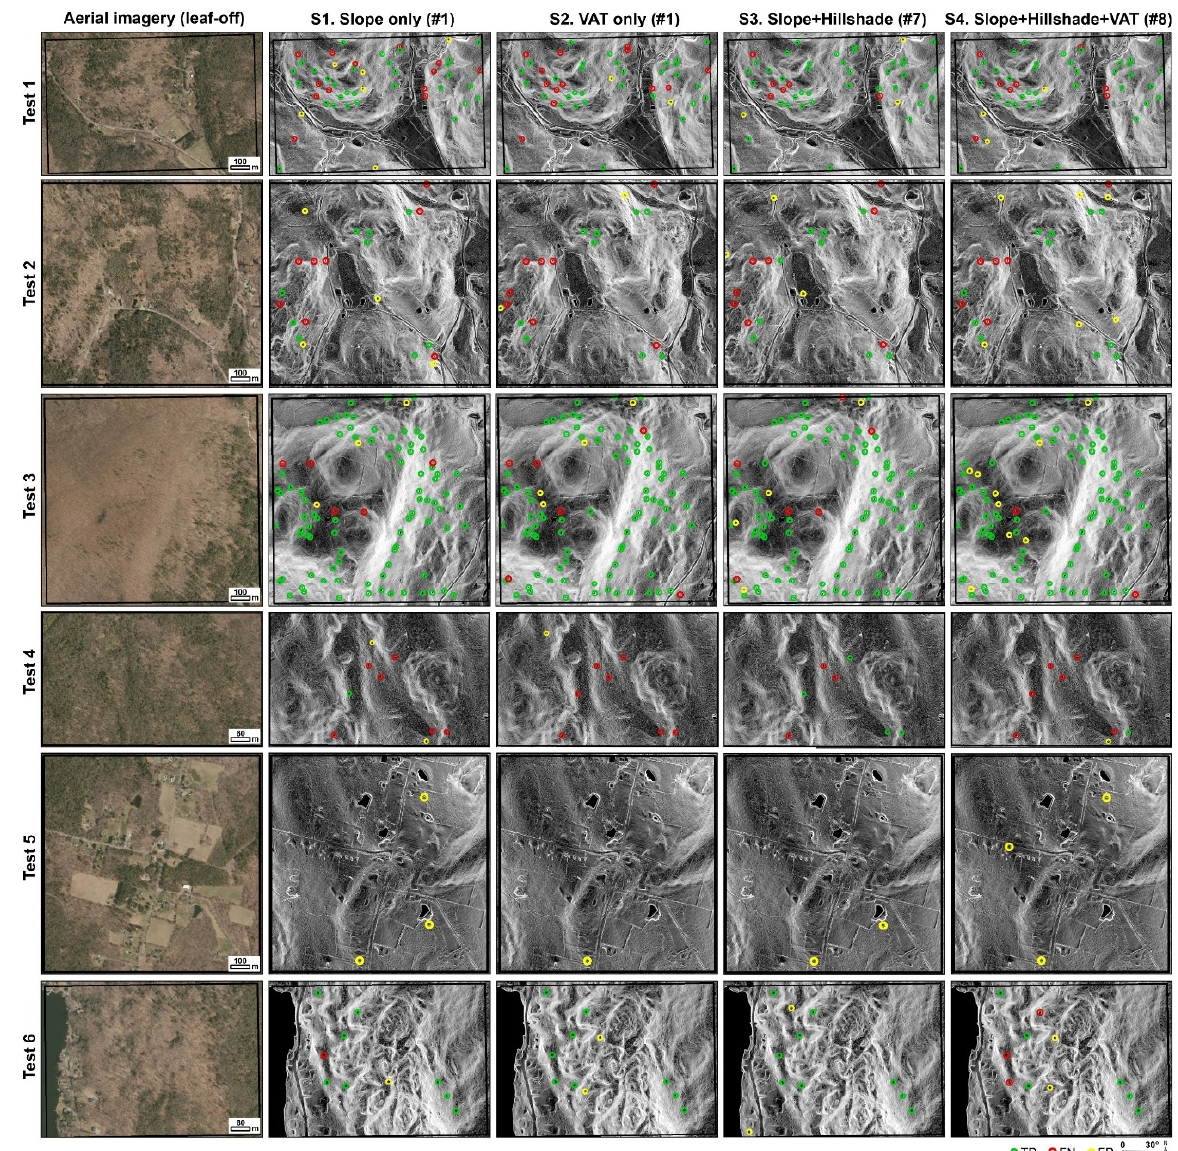
Figure 6. Leaf-off aerial image and model prediction results for test regions 1–6. High resolution aerial images (2016) are provided by [47]. Note that # refers to the number of rasters for the input image. The background image for model prediction results is a slope raster (color ramp: black (low slope) to white (high slope). TP = true positive, FN = false negative, FP = false positive.